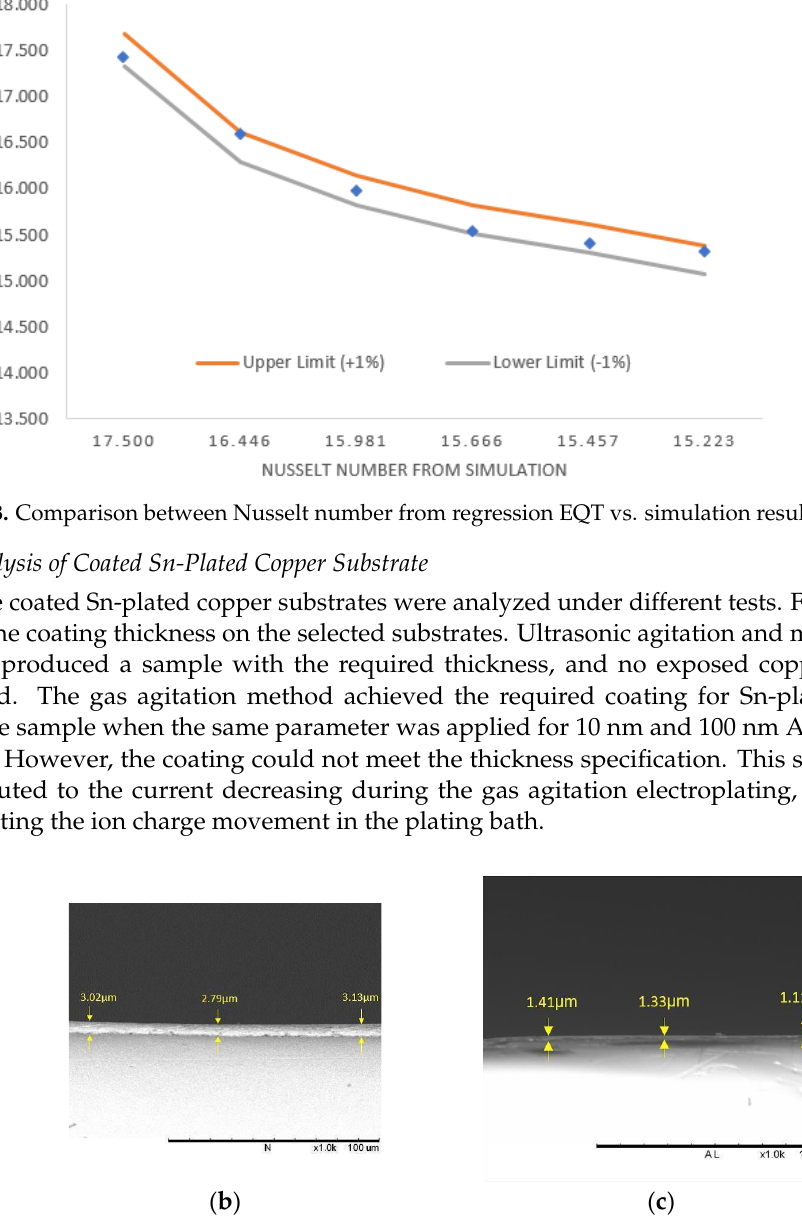
Figure 17. Fitted line plot for Nusselt number vs fin thickness.